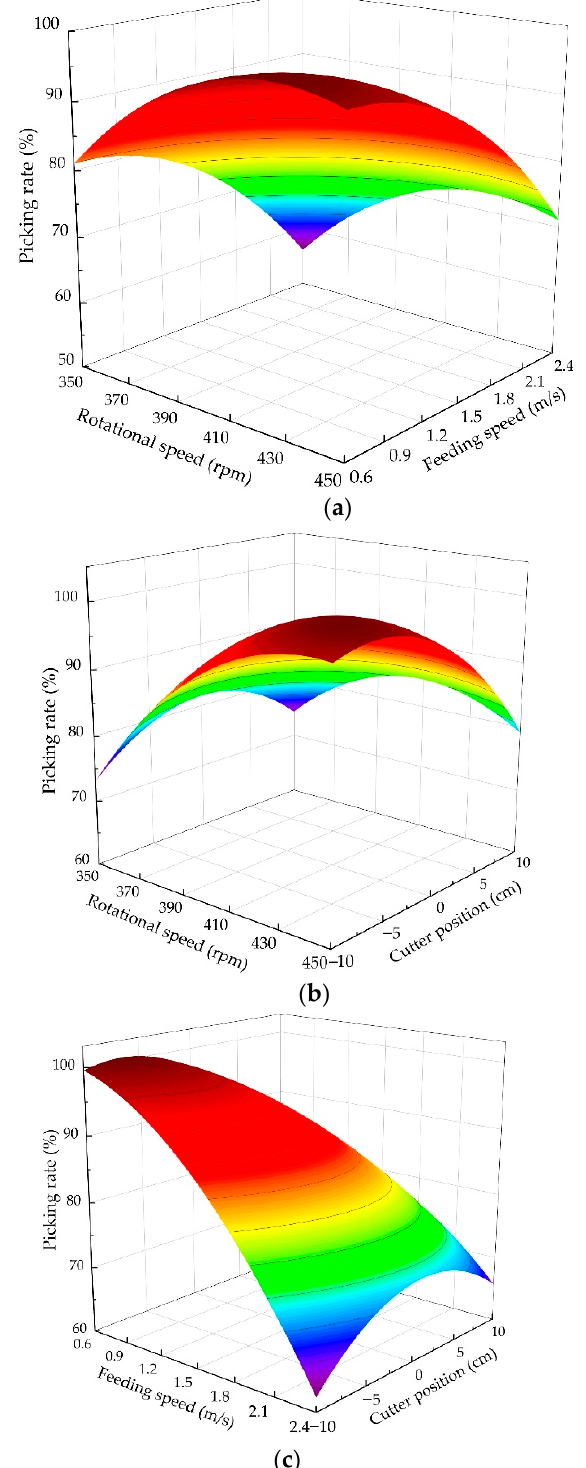
Figure 12. Response surfaces for interaction between the factors. ( a ) clamping picking device speed and stalk feeding speed; ( b ) clamping picking device speed and cutter position, and ( c ) stalk feeding speed and cutter position.